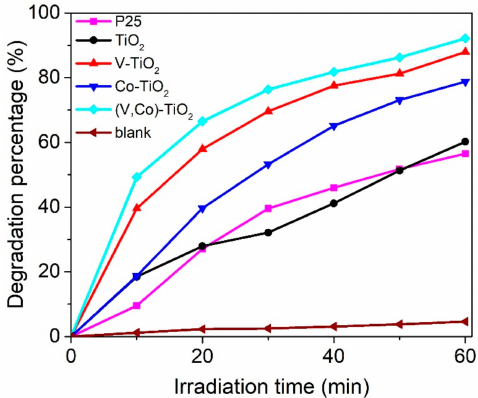
Figure 9. Degradation rate of MB over the P25, TiO 2 , V–TiO 2 , Co–TiO 2 , and (V,Co)–TiO 2 samples and without the catalyst